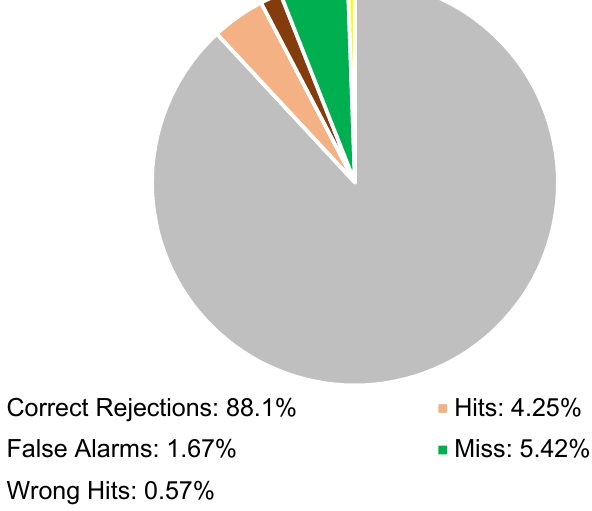
Figure 6. Budgeting for errors and correct predictions. Figure 7 gives a spatial overview of the distribution of errors and correct predictions.